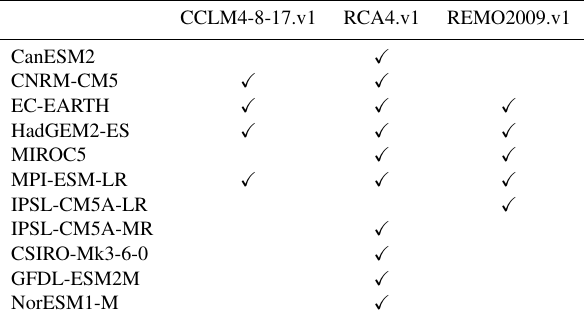
Table 2. Input RCM and GCM simulations used. The CORDEX- Africa simulations are given in the columns. The CMIP5 GCMs used as driving fields are given in the